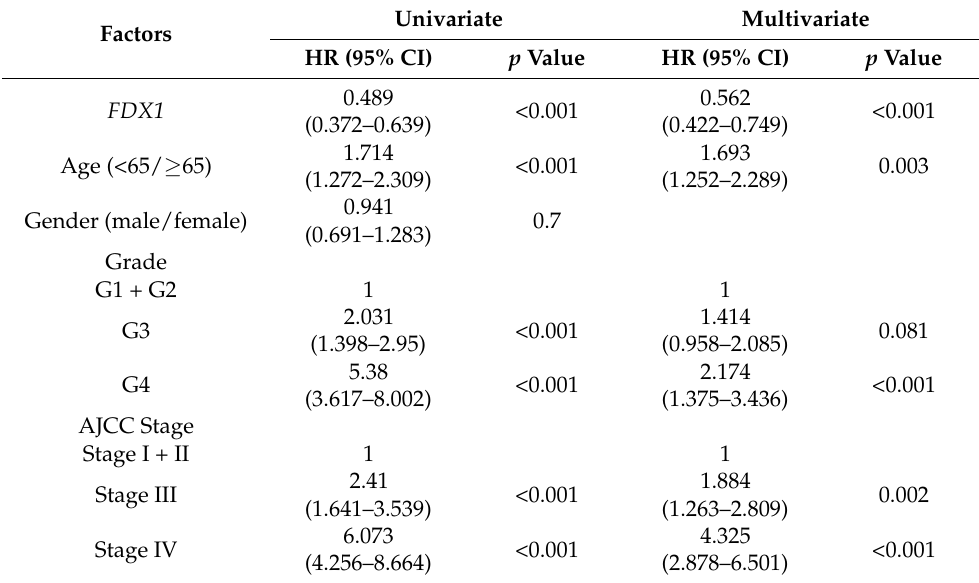
Table 3. Univariate and multivariate Cox regression analyses for predicting